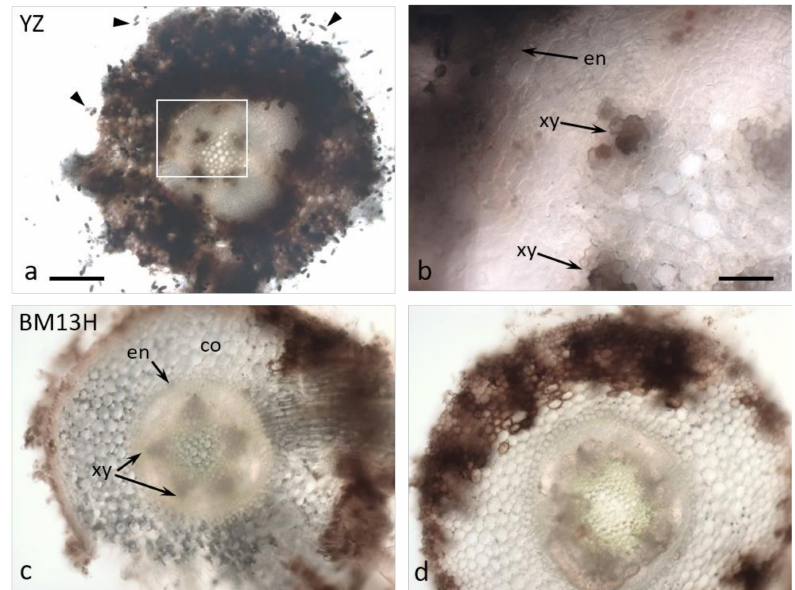
Figure 4. Cross-sections of roots from susceptible (YZ— a , b ) and resistant (BM13H— c , d ) G. arboreum seedlings 10 days after inoculation with BRR spores in sterile culture. ( a , b ) Abundant spores emerge from the surface of YZ roots (arrowheads in a ), the cortex (co) is very heavily colonized, and black fungal hyphae commonly penetrate through the endodermis (en) and colonize the xylem (xy). b = enlarged area outlined in a . ( c , d ) There is less fungal colonization of BM13H roots and penetration through the endodermis is rare. co = cortex, en = endodermis, xy = xylem poles (2 of 5 indicated) Bar in a for a , c , d = 0.2 mm, bar in c = 50